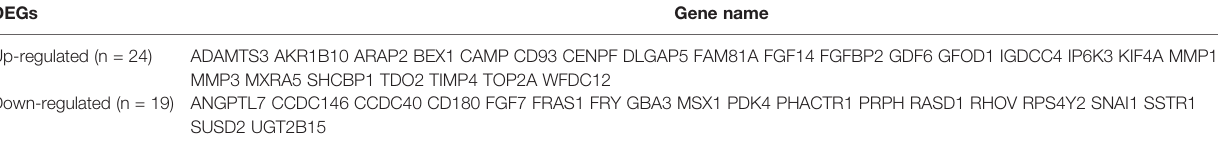
TABLE 2 | Differentially expressed genes from the two datasets.